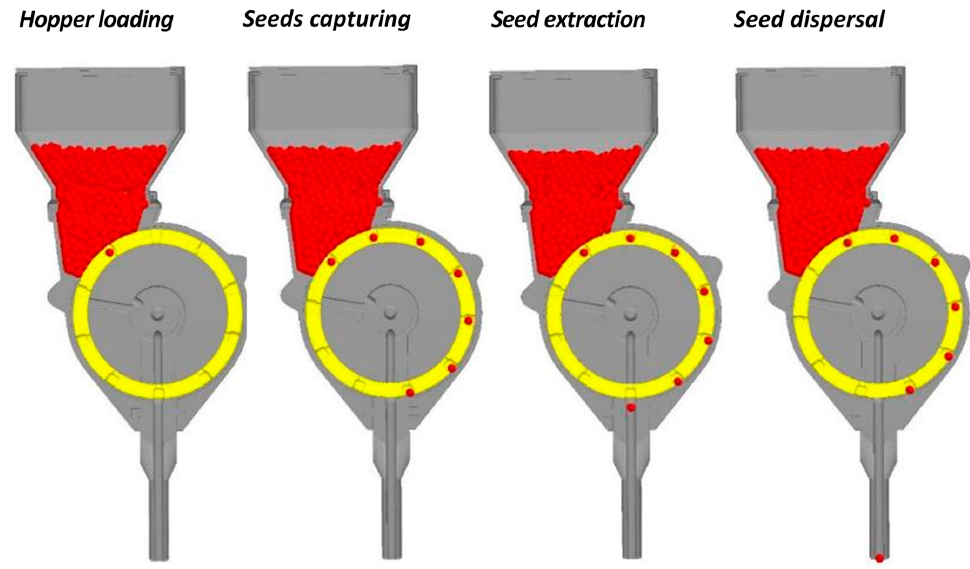
Figure 15. The main stages of simulating the operation of the seed sowing device.